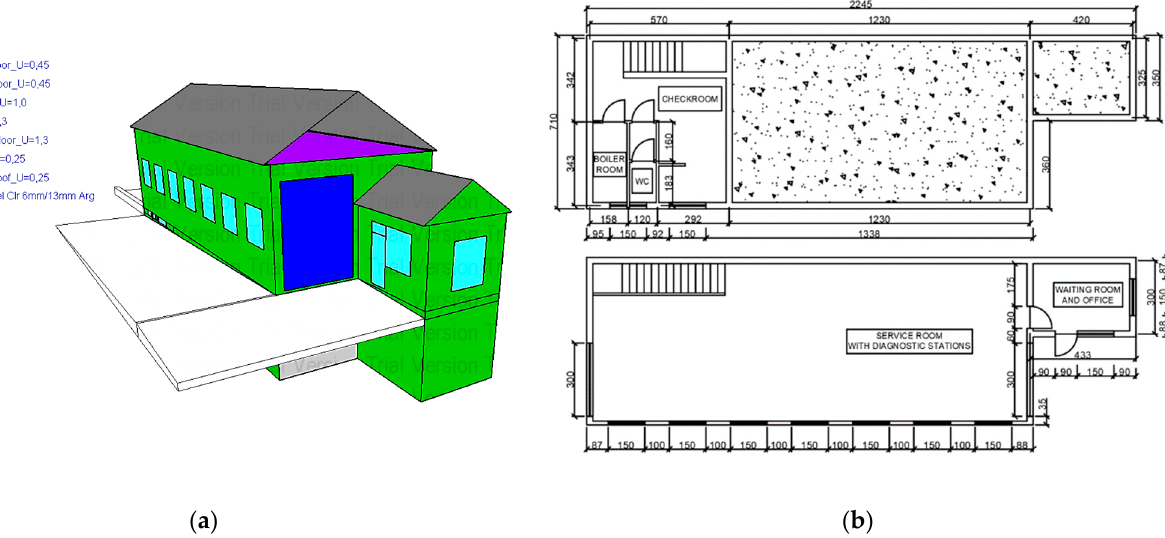
Figure 2. Analysed service building: ( a ) Model of the building with partitions data; ( b ) Plan of the basement and first floor of the